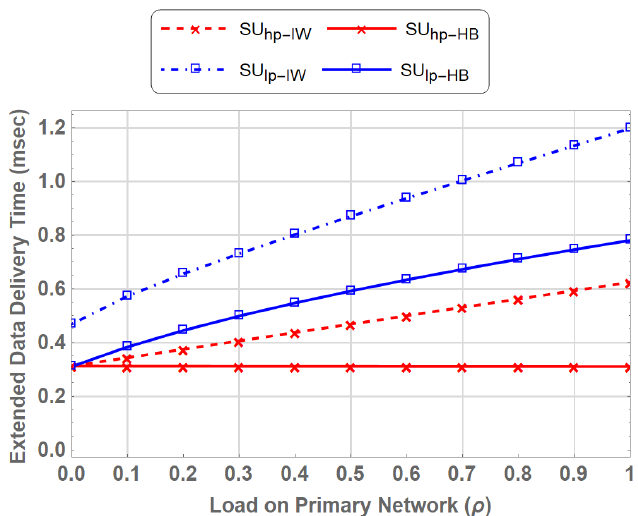
Figure 17. Comparison of Extended Data Delivery Time for PN-MC-IW and PN-MC-HB.